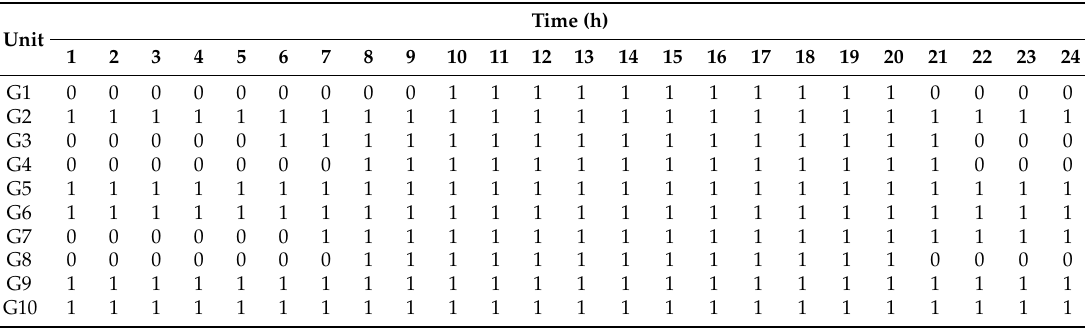
Table 4. Unit commitment schedule obtained using Algorithm 1.